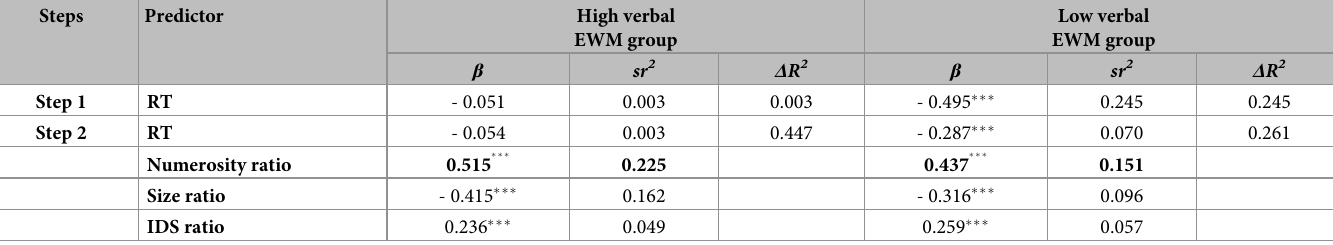
Table 4. Results of hierarchical regression on Numerosity Comparison accuracy of high vs. low verbal EWM